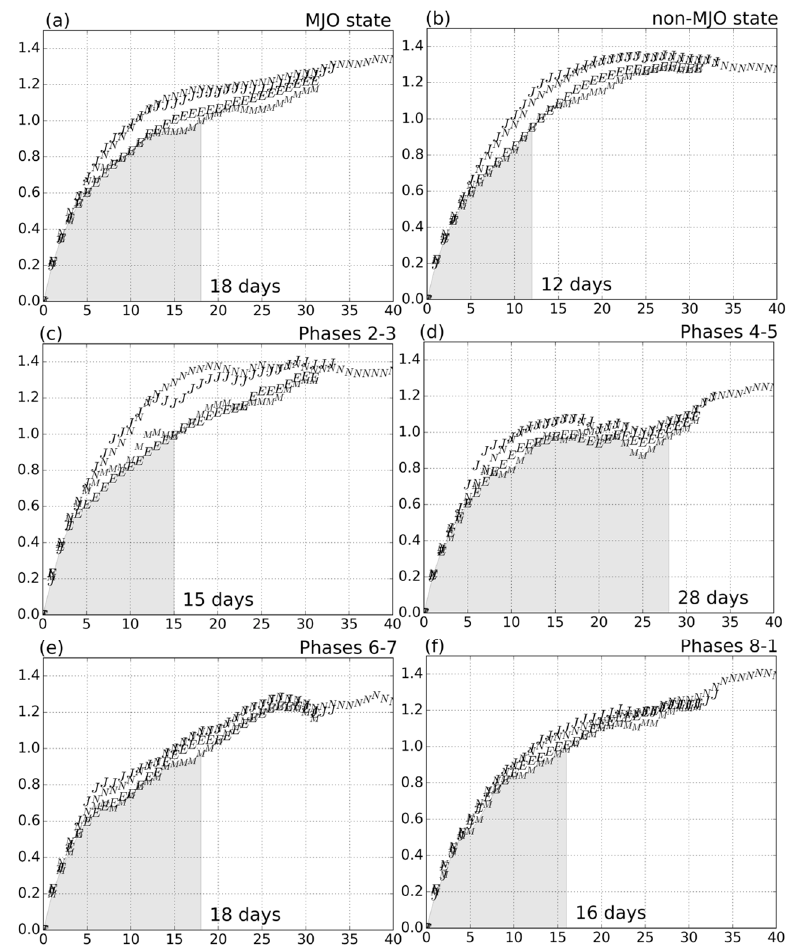
Figure 9. ( a , b ) Initial-value error for the ECMWF (mark E), JMA (mark J) and NCEP (mark N) models, and the multimodel average (mark M), averaged over forecasts of which the initial MJO amplitude is ( a ) more than, and ( b ) less than unity. ( c – f ) Initial-value error averaged over forecasts starting from ( c ) Phases 2–3, ( d ) Phases 4–5, ( e ) Phases 6–7 and ( f ) Phases 8–1.